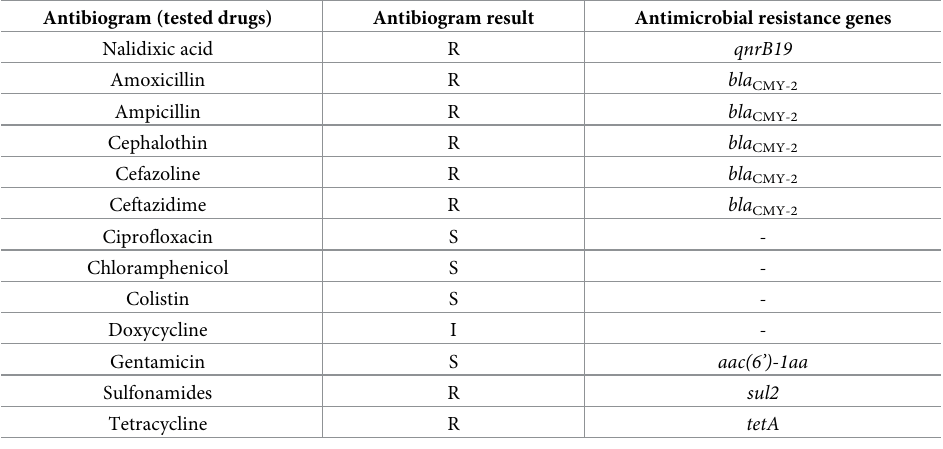
Table 5. Antibiogram and detection of antimicrobial resistance genes from the Salmonella enterica serovar Min- nesota isolate from a poultry slaughterhouse located in the Federal District, carried out using the disk diffusion assay (CLSI, 2020) and WGS, respectively.